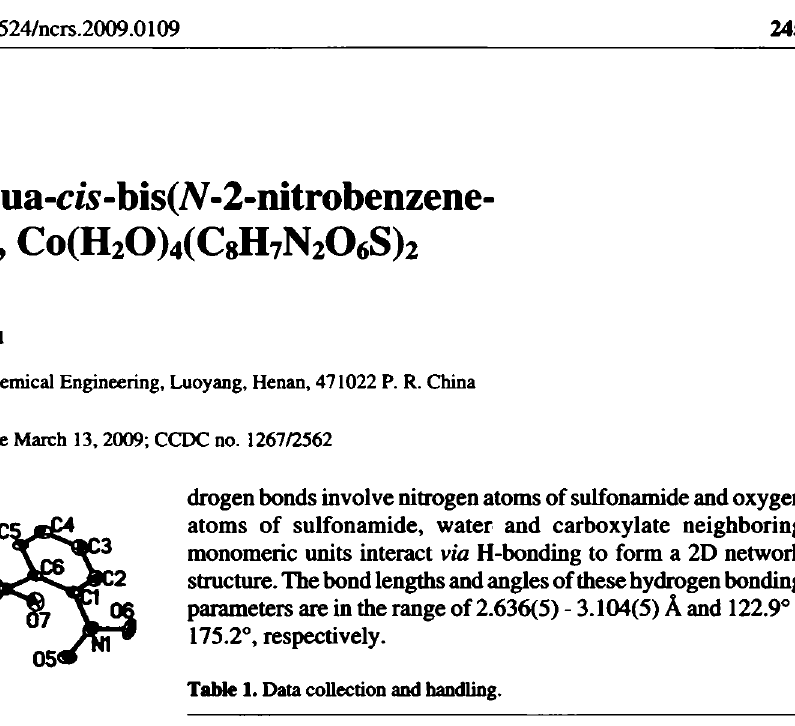
Table 1. Data collection and handling.